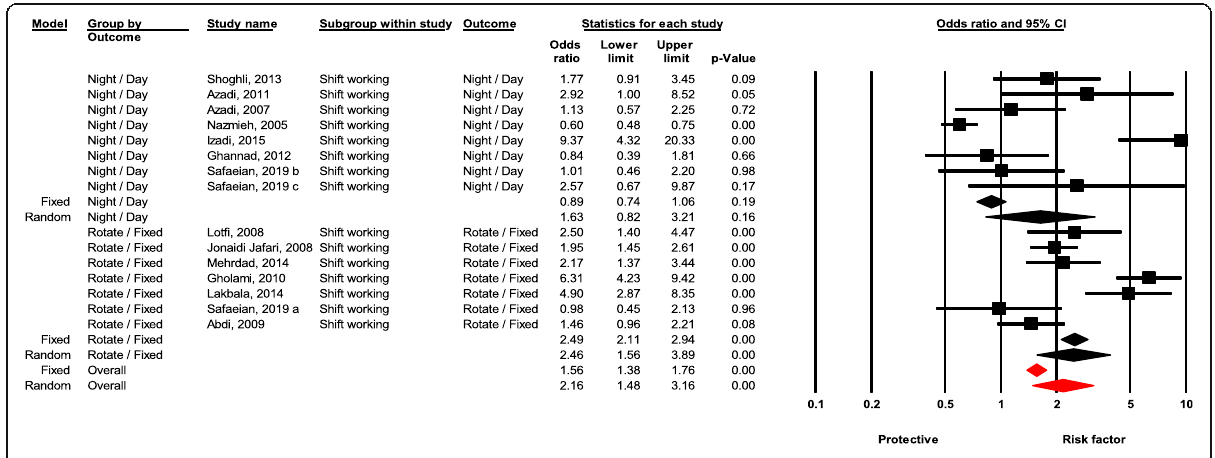
Fig. 8 Forest plot for relationship between shift working and risk of NSI in Iran